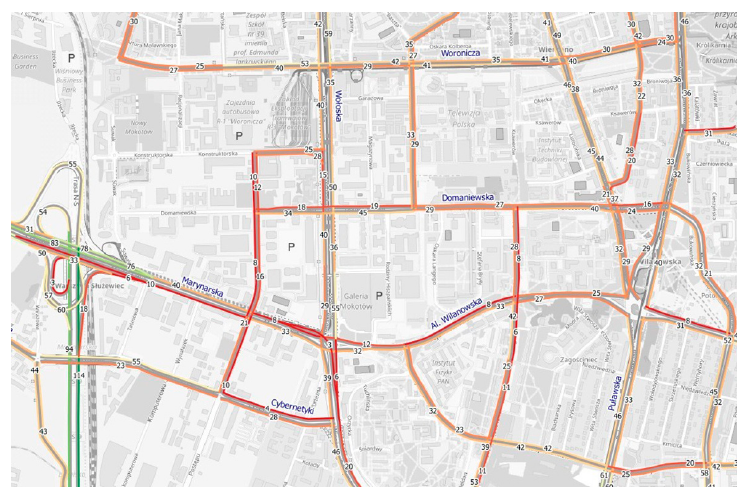
Figure 13. Average speed on the streets of “Mordor” during rush hours (based on monitoring data provided by CE-Traffic, a.s.).